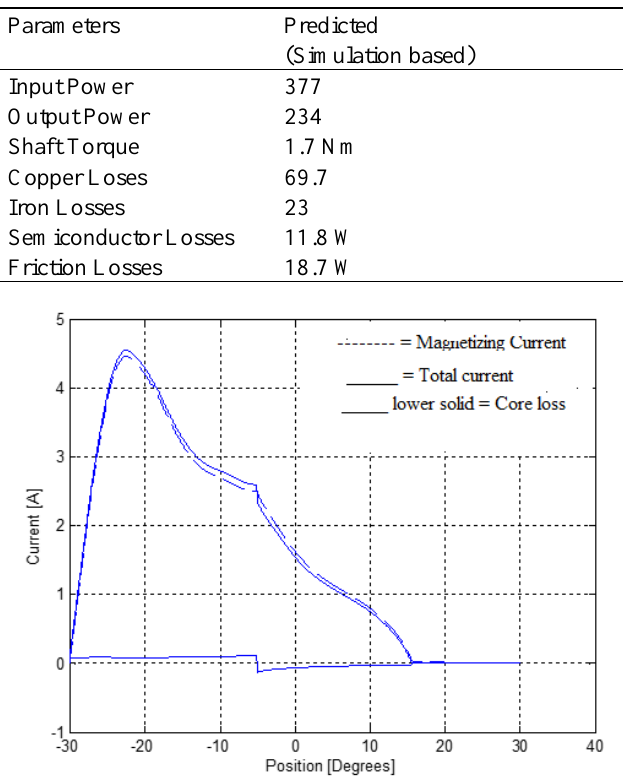
Fig. 12. Representation of current waveforms at conduction angle of 25 0 deg in single-pulse